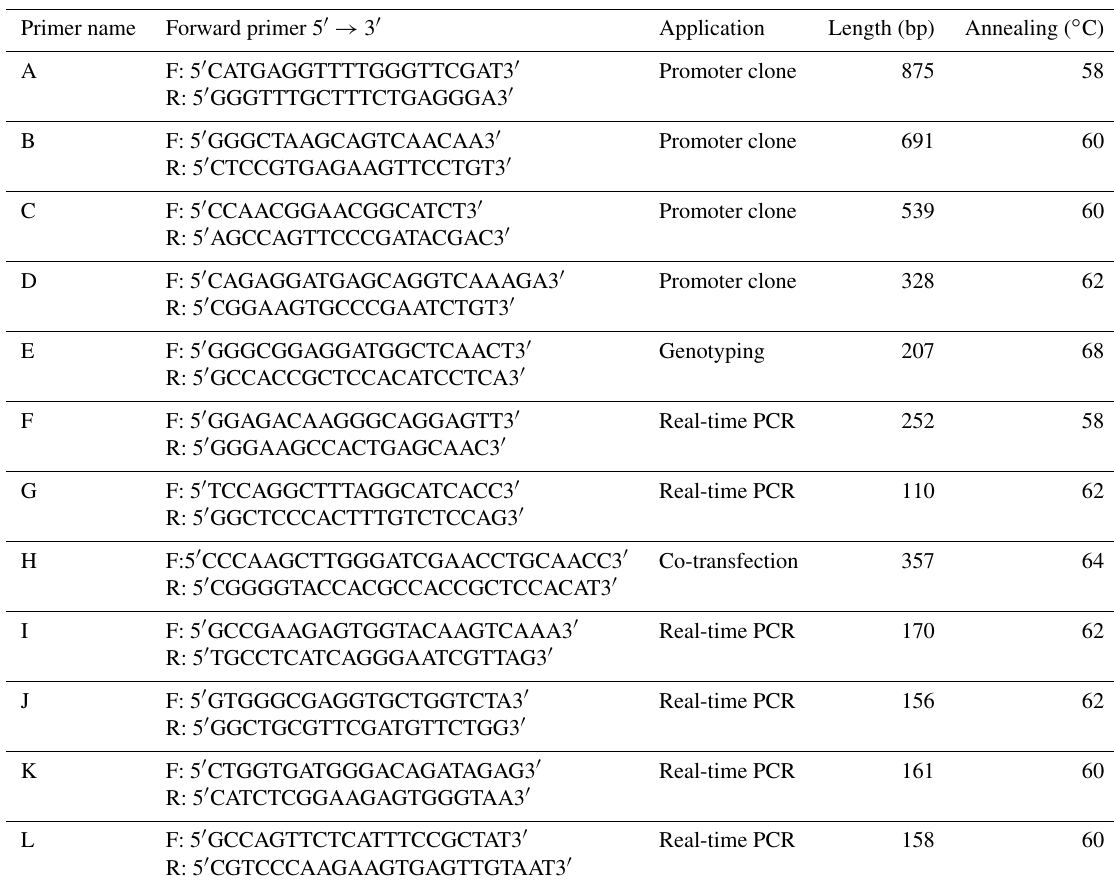
Table 1. Primers used in this study. Primer